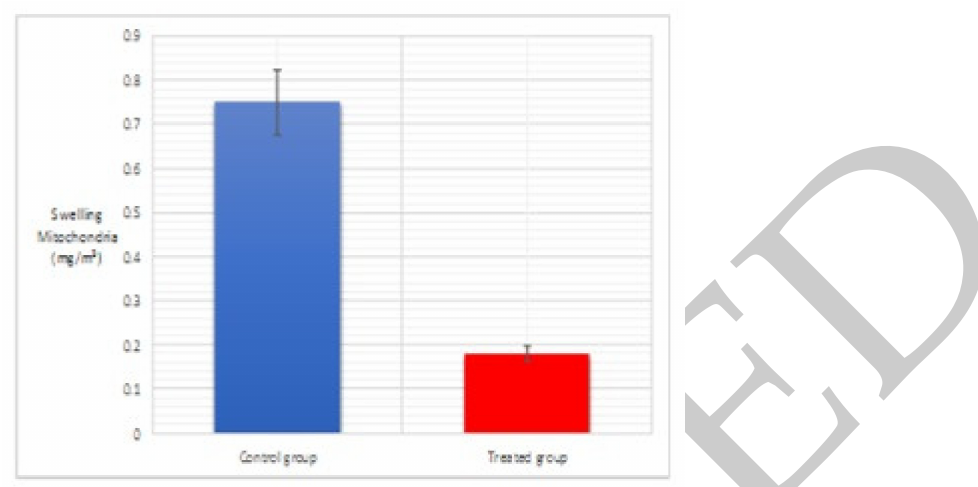
Figure 7. Swelling mitochondria in the serum were detected in diabetic untreated and treated group with C. molle.